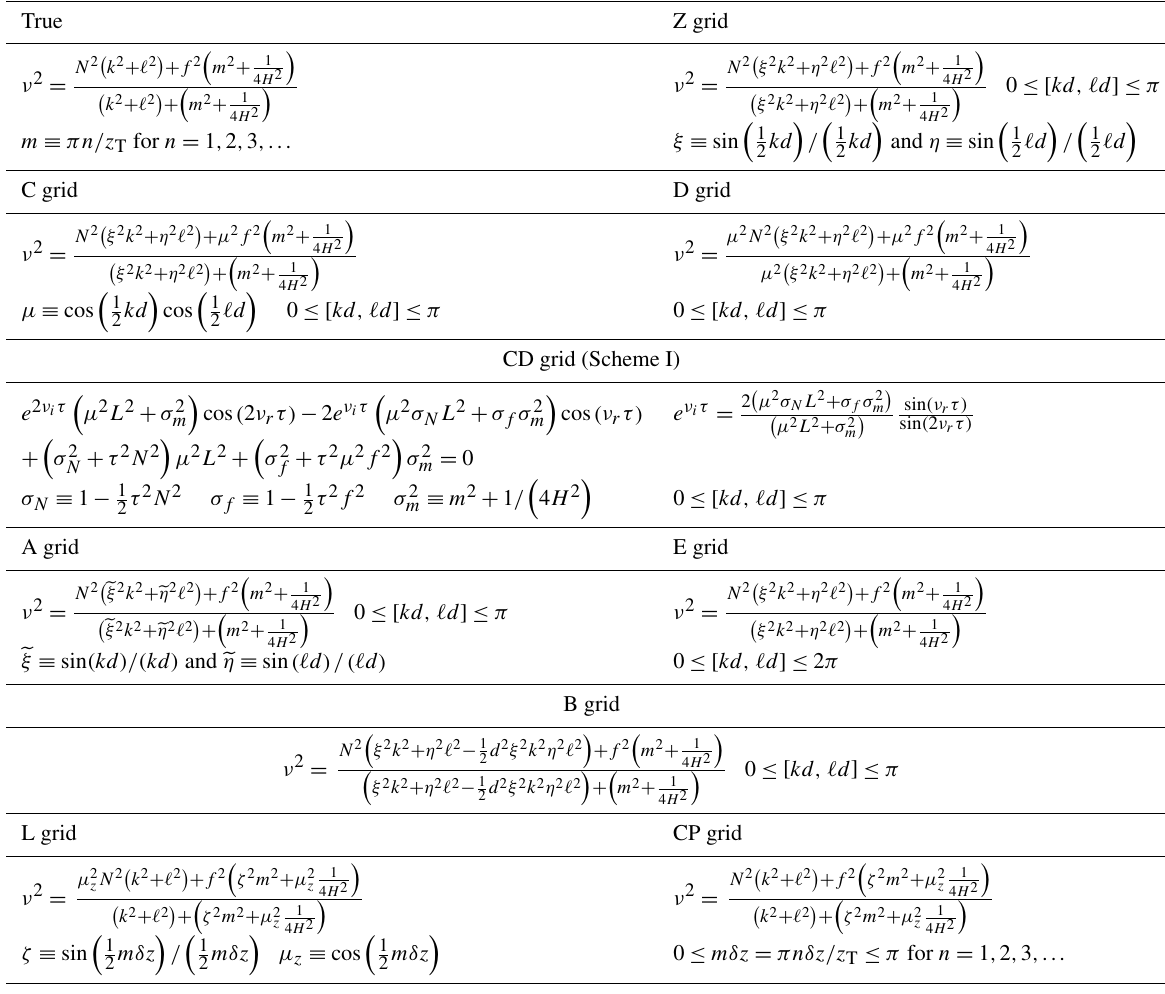
Table 2. A summary of the true and discrete dispersion relations for the horizontal and vertical grids discussed in this paper. True Z grid (cid:16) m 2 + 1 N 2 (cid:0) k 2 + (cid:96) 2 (cid:1) + f 2 4 H 2 ν 2 =